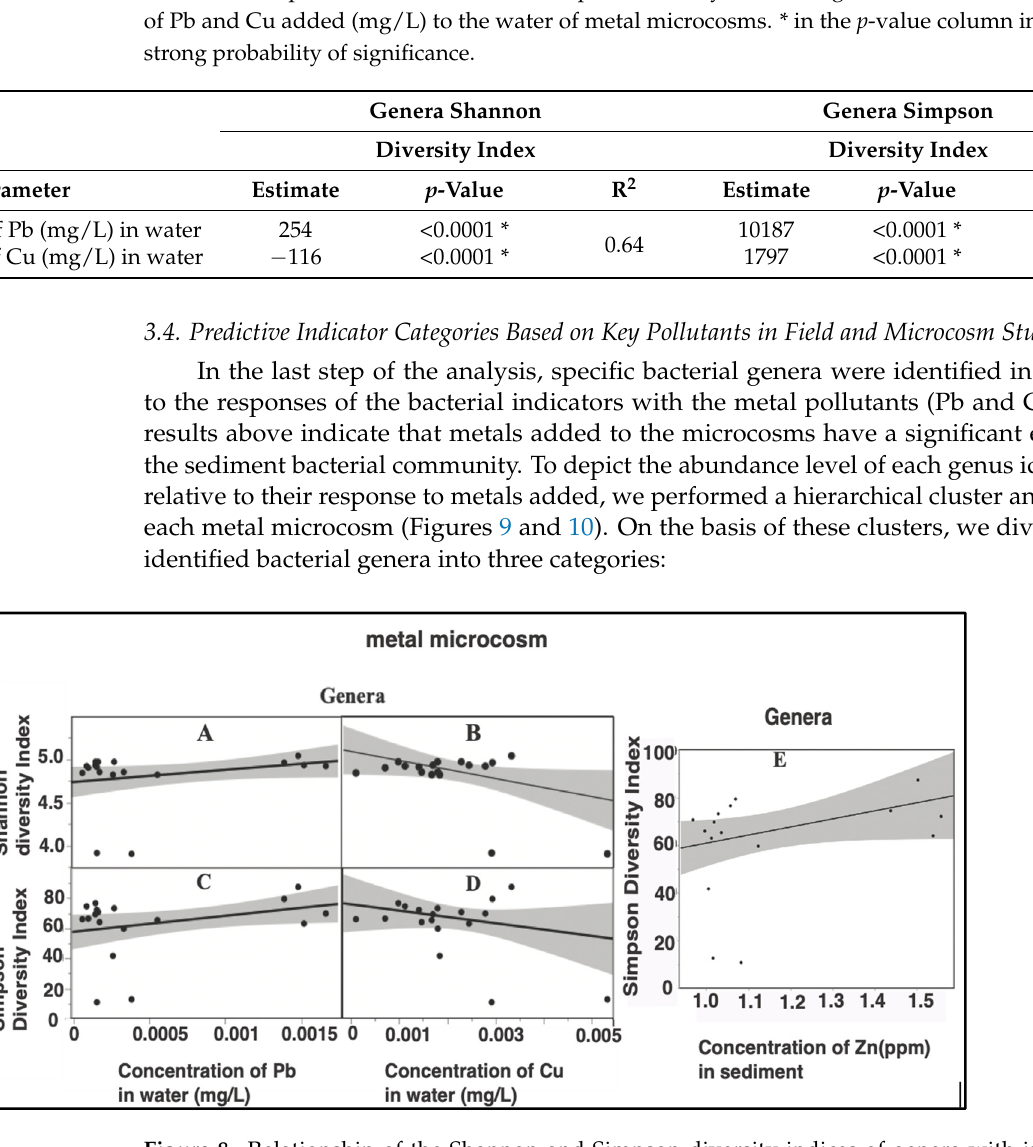
Figure 8. Relationship of the Shannon and Simpson diversity indices of genera with increasing concentrations of Pb ( A , C ) and Cu ( B , D ) in microcosm water (mg/L), along with the relationship between the Simpson diversity index of genera and increasing concentrations of Zn ( E ) in the sediment (ppm). All other statistically non-significant relationship between detected sediment metals in the metal microcosm and diversity indices of genera are listed in Appendix A Table A4. Table 3. Multiple regression model with estimate (slope), p -value (significance), and combined R 2 of the relationship between Shannon and Simpson diversity indices of genera and the concentration of Pb and Cu added (mg/L) to the water of metal microcosms. * in the p-value column indicates a strong probability of significance.